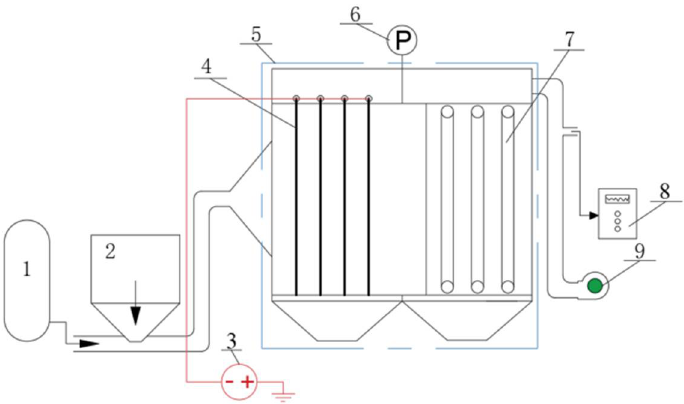
Figure 1. Schematic diagram of the experimental setup: 1. compressed air; 2. particle generator; 3. high−voltage power source; 4. discharge wires; 5. hybrid electrostatic precipitators; 6. pressure meter; 7. filter bag; 8. ELPI; 9. induced draft fan.